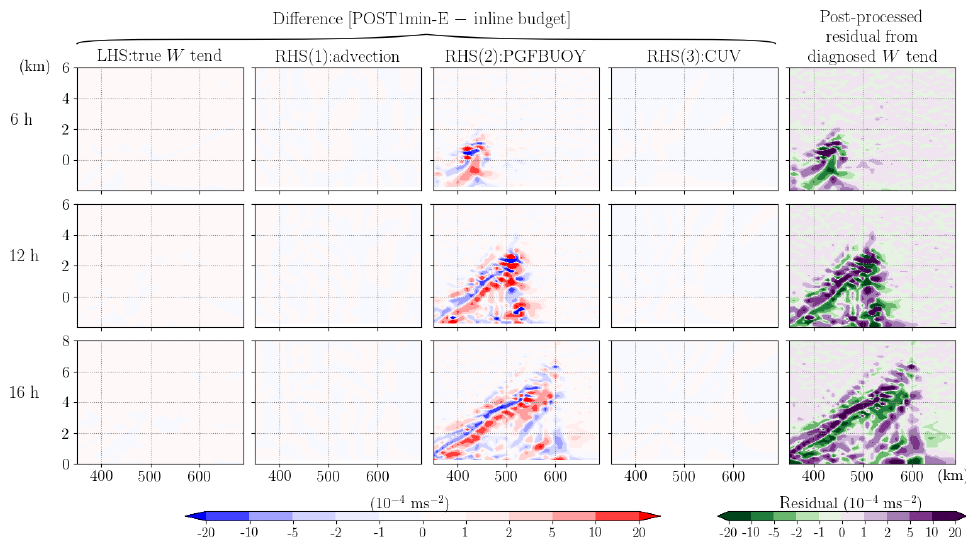
Figure 15. The difference between the post-processed (POST1min-E) and the inline budget analysis for vertical momentum W . All terms have been divided by µ d and thus have a uniform unit of meters per second squared. In each row, the subplots from left to right indicate the difference of true W tendency, ADV, PGFBUOY, and CUV. The rightmost subplot indicates the residual term obtained in the post-processed budget analysis. Each row from top to bottom shows the results at 6, 12, and 16h,